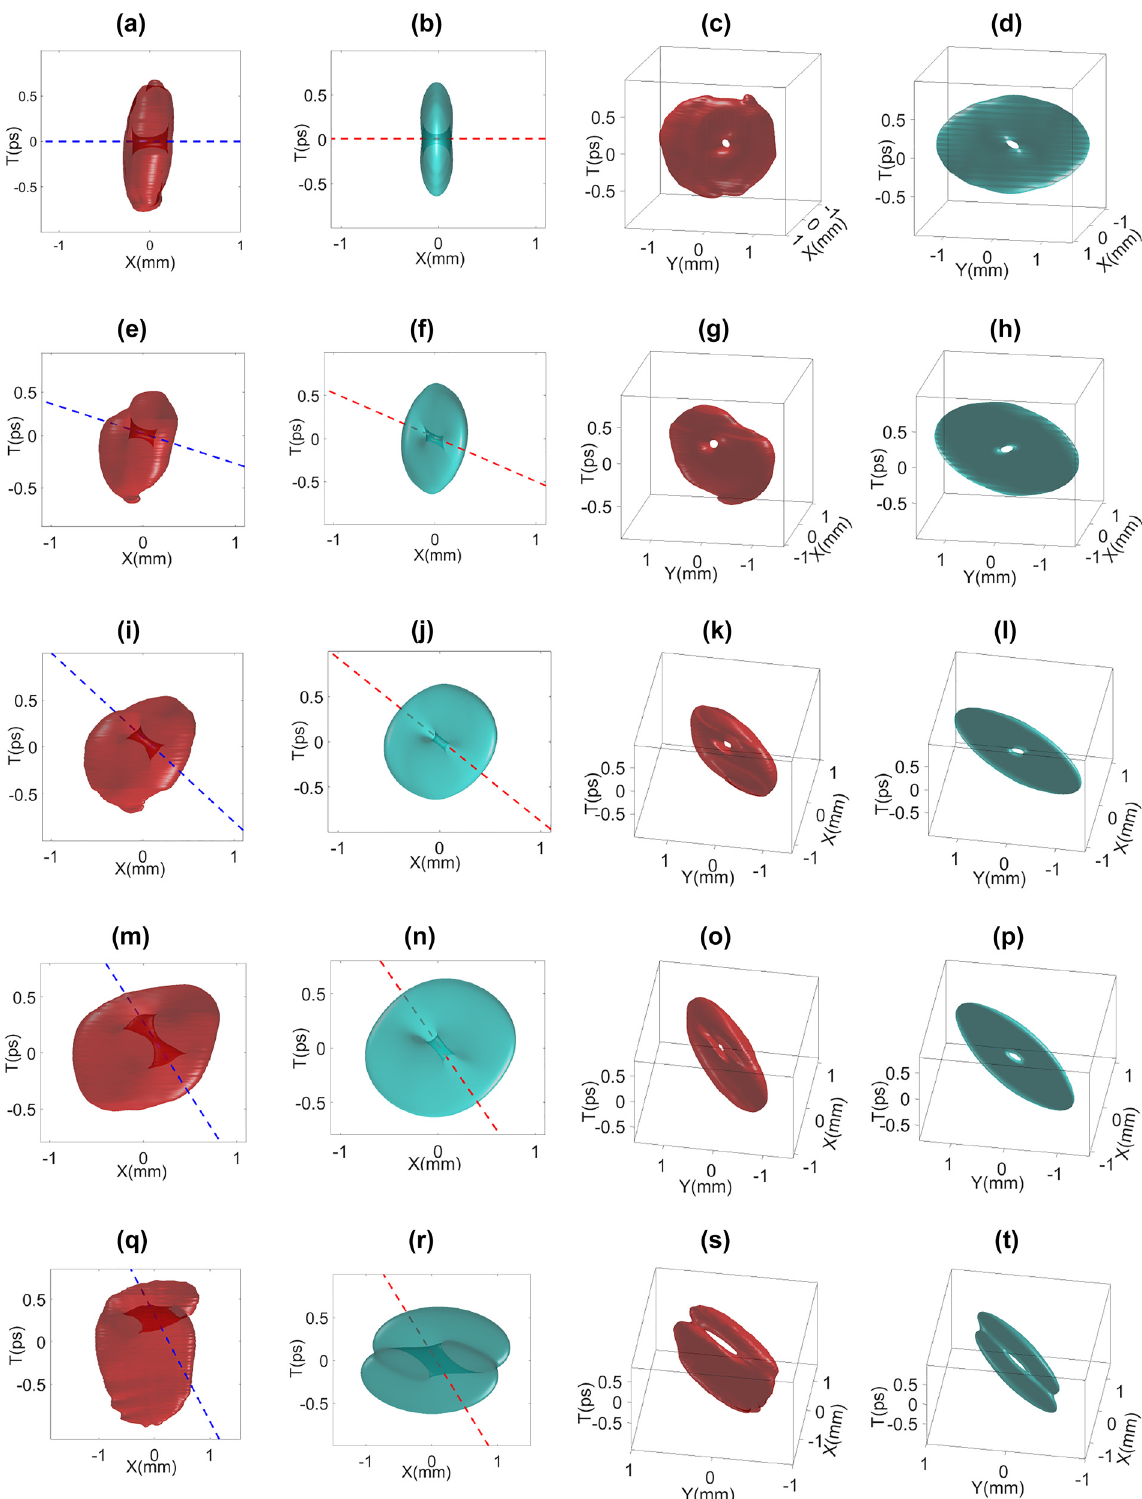
Figure 6: Experimental and simulated iso-intensity plots of the STOV with arbitrary OAM tilt generated by cylindrical lens system with different rotational angles. STOVs in red represent experimental data and STOVs in green represent simulation results. Two views of iso-intensity plots are demonstrated: x − t domain view and the three-dimensional view (viewpoint is adjusted according to the tilt of the = 0; (e)–(h): 𝜃 = 10 ◦ ; (i)–(l): 𝜃 = 20 ◦ ; (m)–(p): 𝜃 = 45 ◦ ; (q)–(t): 𝜃 = 60 ◦ ; Dashed line in color represents vortex STOV: (a)–(d): 𝜃 r r r r r